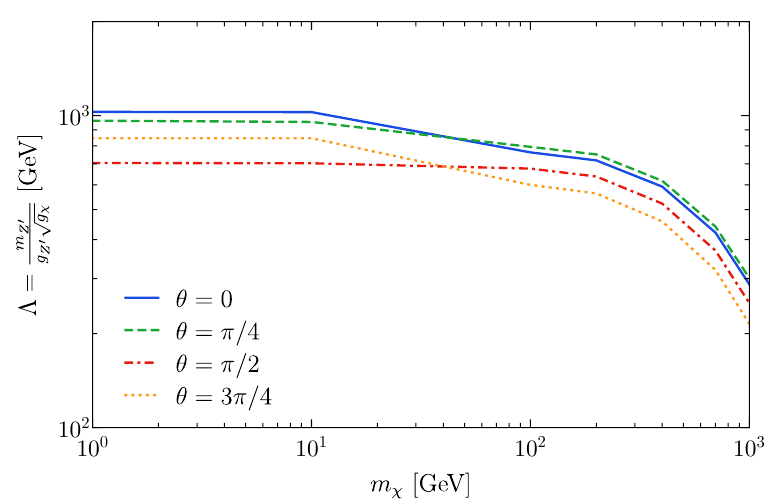
Figure 3 . ( Replaces (cid:12)gure 3 of the original paper .) Bounds on (cid:3) for each value of (cid:18) from the monojet search.